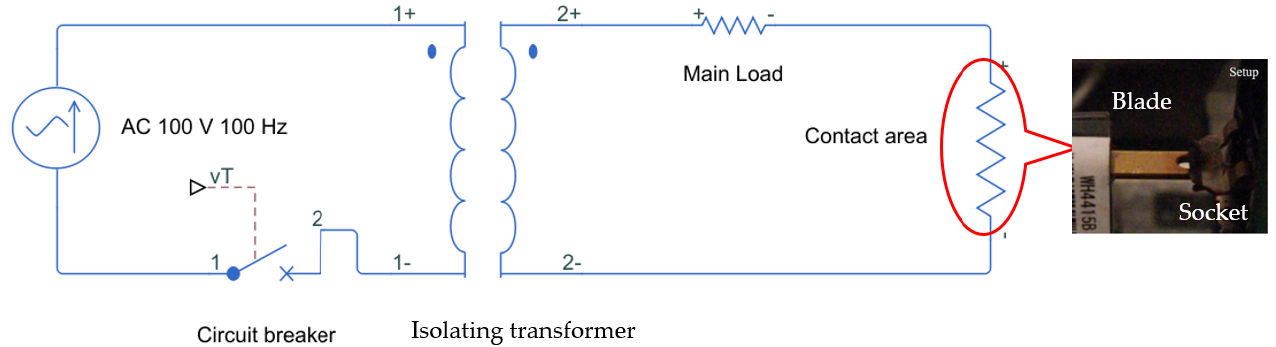
Figure 1. Equivalent circuit diagram of the experiment setup. Note that the setup does not have capacitors for power factor correction connected to the isolating transformer. The setup near the contact area is shown in the embedded picture. Probe A is the neutral line and Probe B is the hotline. Experiment Samples and Current Source